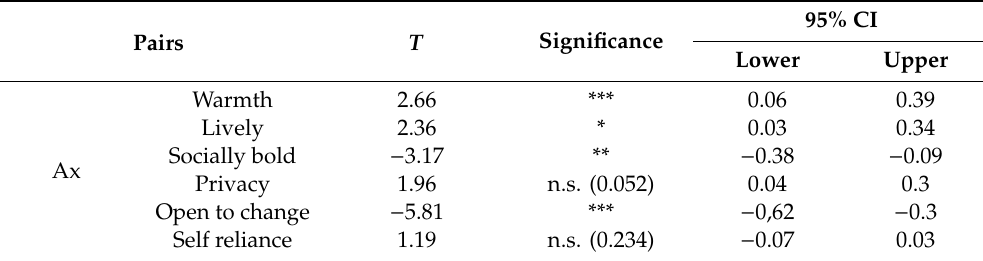
Table 4. Correlation pairs to anxiety and empathy